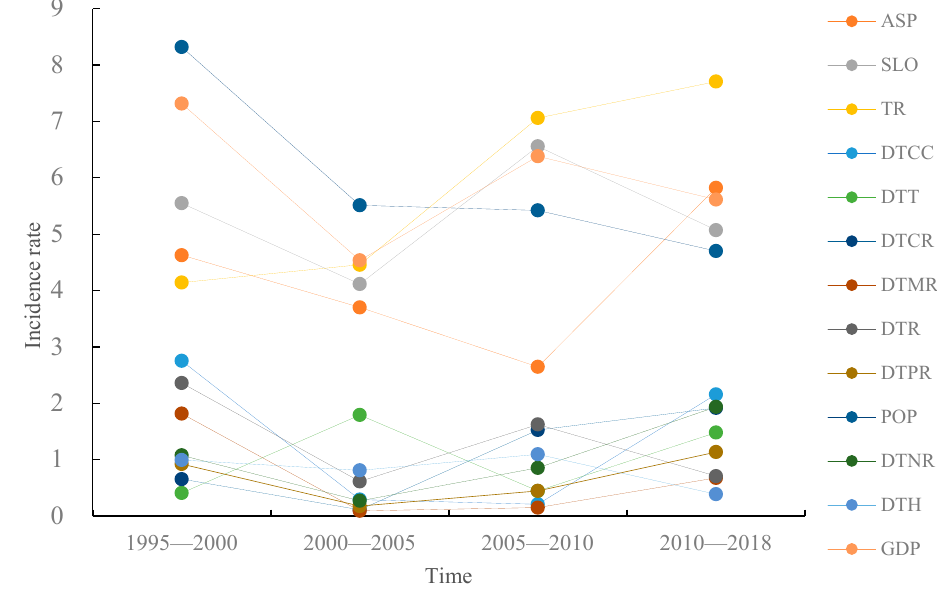
Figure 9. The positive incidence rate of GAPT.